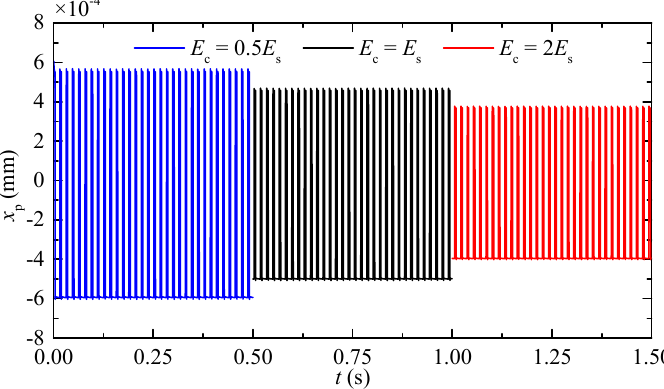
Figure 8. Vibration displacements along OLOA under different coating elastic moduli.